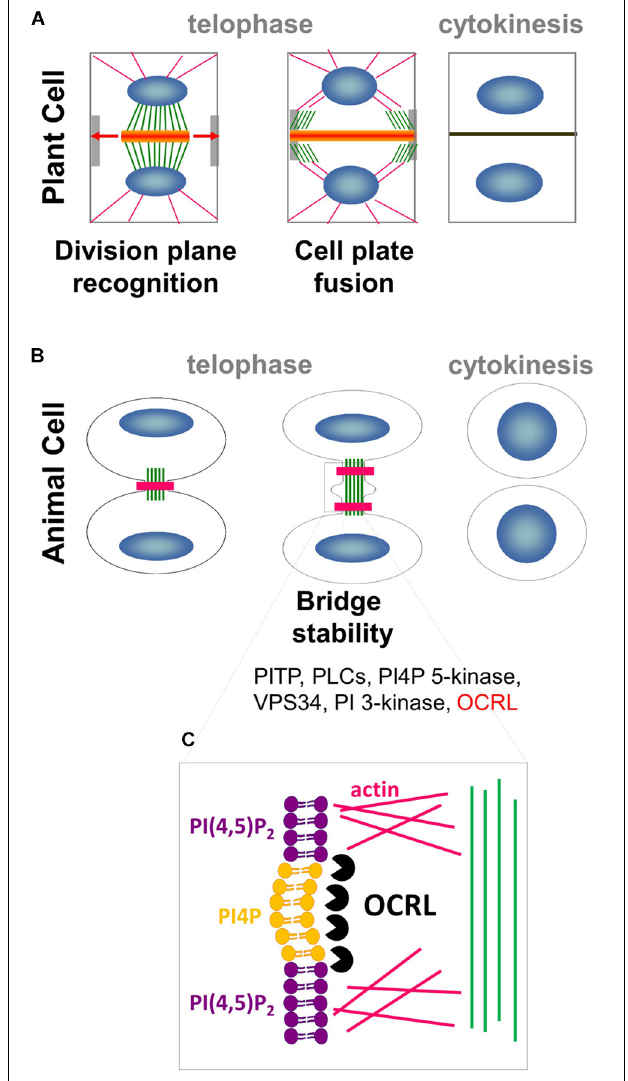
FIGURE 1 | Interplay between PIPs, cytoskeleton and membrane trafficking. (A) In plant cell, phragmoplast of MTs (green) and actin filaments (pink) arises between daughter nuclei (blue), and guides the movement of Golgi-derived vesicles (orange) containing cell wall materials to the cell plate. As cytokinesis proceeds, the phragmoplast expands laterally (arrows) until it fuses with the parental PM and cell wall at the cortical division site (light gray). (B) In animal cells, a contractile actomyosin ring (pink) that mediates ingression of the cleavage furrow is formed. Successful cytokinesis is completed with abscission of the two cells at the midbody ring (green). Note that most of the PIPs modifiers (in black) are conserved in plant whereas OCRL (in red) has no homolog in the green lineage. (C) In animal cells, PI(4,5)P 2 hydrolysis via OCRL (black packman) is important for normal cytokinesis abscission to locally remodel the F-actin cytoskeleton (pink) in the intercellular bridge during